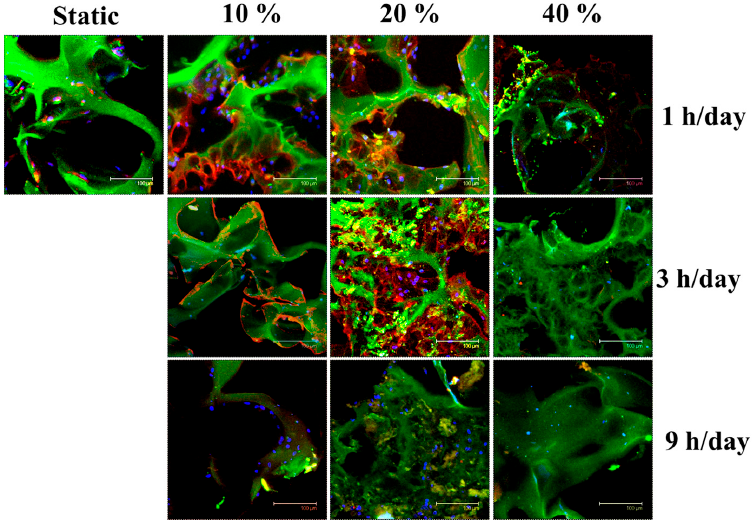
Figure 3. Immunofluorescence staining of chondrocytes in the cryogel scaffolds in static or dynamic culture (frequency = 1 Hz) with different cyclic compressive-loading conditions. Blue: cell nucleus (DAPI); red: Col II (Cy 3); green: gelatin (FITC); scale bar = 100 µm. DAPI: 4 ′ ,6-diamidino-2- phenylindole; Cy 3: Cyanine 3; FITC: Fluorescein isothiocyanate.